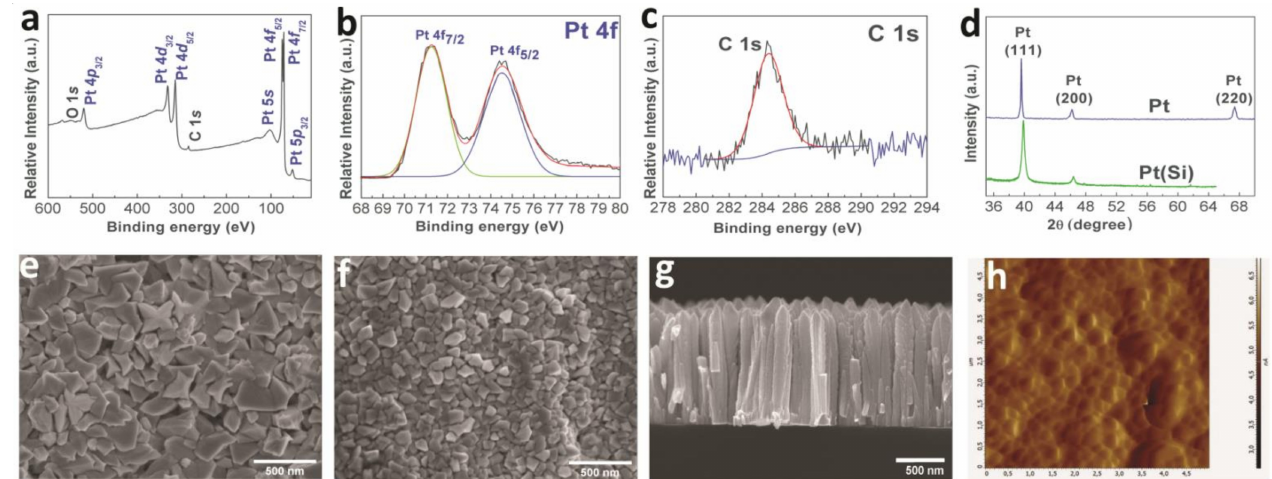
Figure 2. XPS spectra of Pt(Si) sample after etching with Ar + ( a ), fitting of Pt 4 f spectra ( b ), and fitting of C1 s spectra ( c ); XRD patterns of Pt and Pt(Si) samples ( d ); SEM micrographs of the sample surface (Pt ( e ) and Pt(Si) ( f )) and cross-section of Pt(Si) sample ( g ); AFM micrograph Pt sample ( h